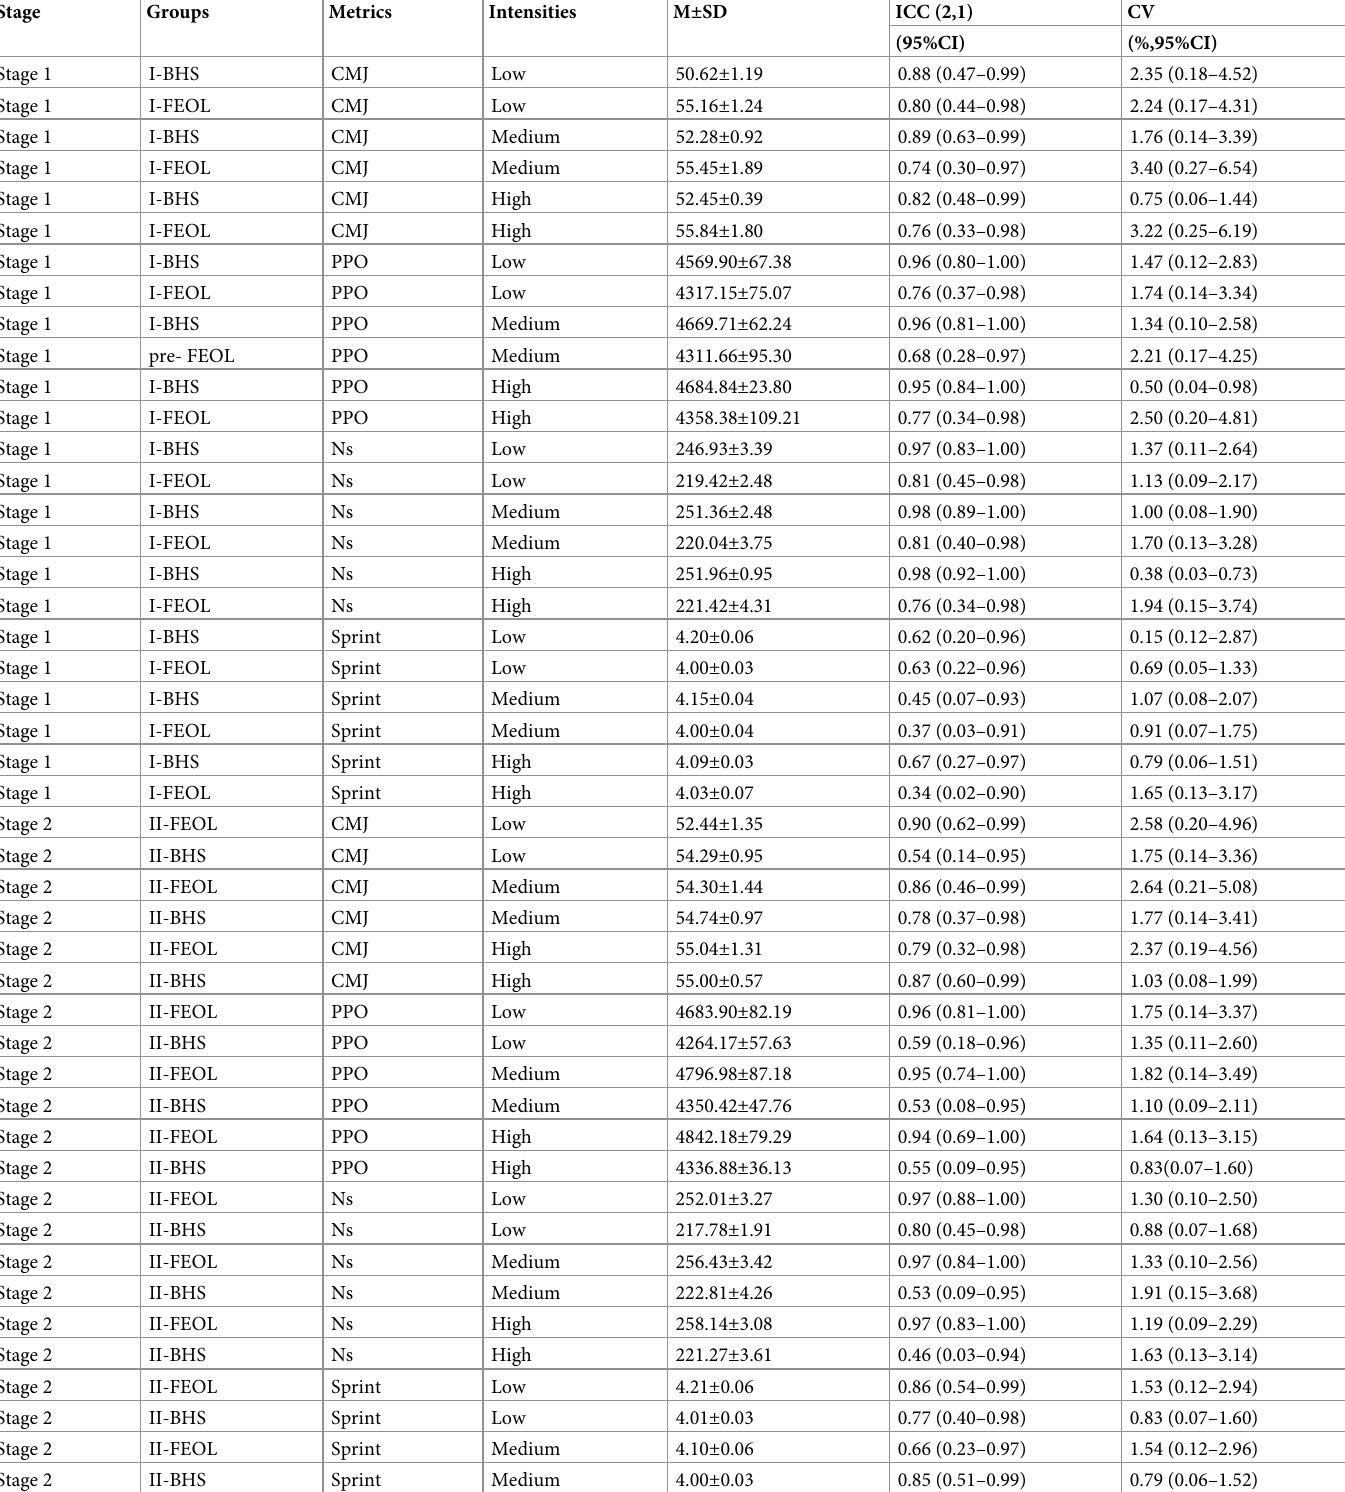
Table 2. Mean test ± standard deviations (SD), test